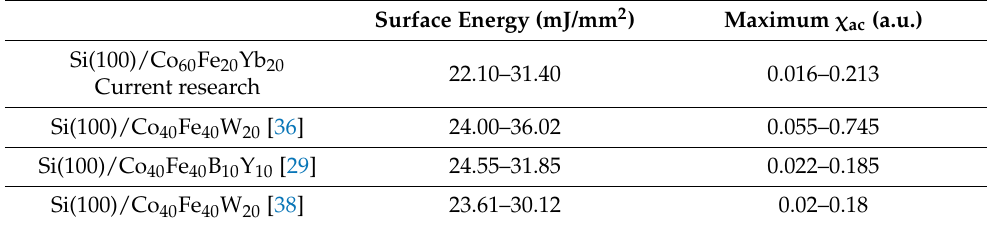
Table 4. Comparing surface energy for specific CoFeW and CoFeBY thin films from Si(100)